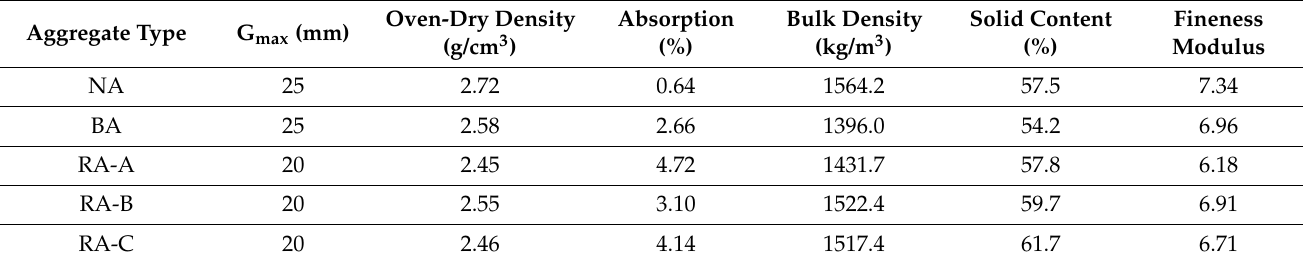
Table 5. Physical properties of coarse aggregates.